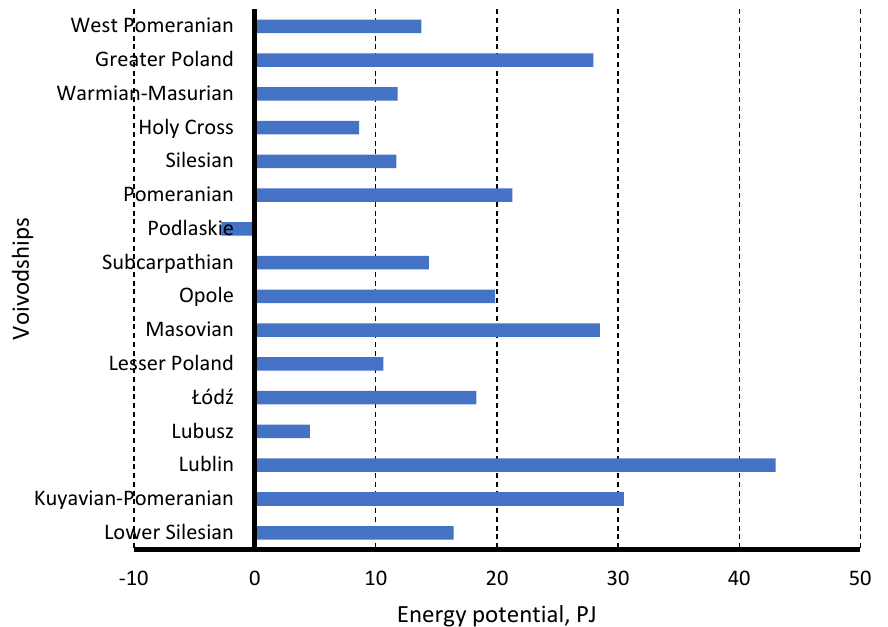
Figure 7. Voivodship bioenergy potential in 2018.